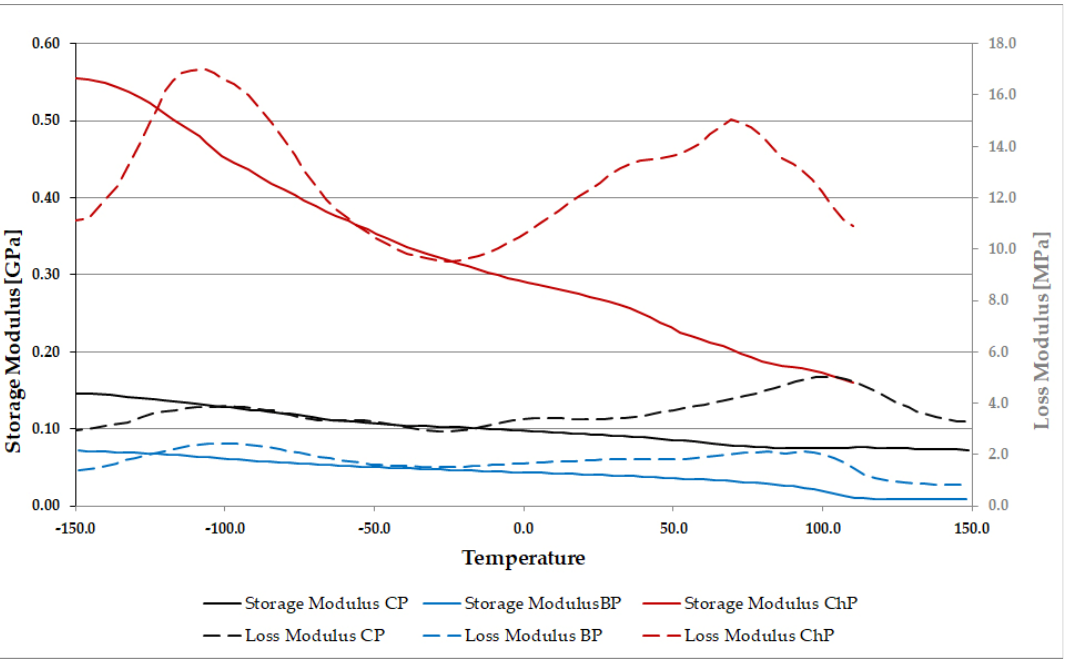
Figure 3. Comparison of storage modulus (E ′ ) and loss modulus (E ″ ) exemplary graphs for contem- porary pine: undegraded (CP), biologically degraded (BP) and chemically degraded (ChP).